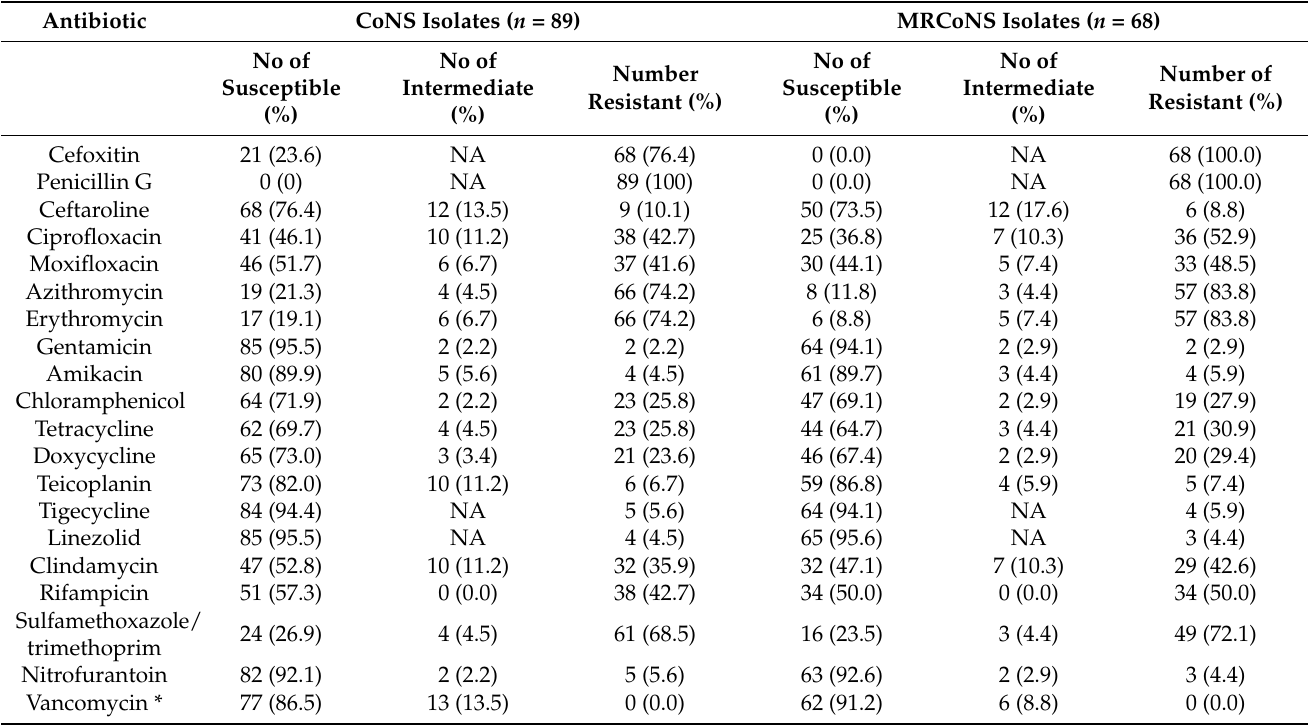
Table 1. Antimicrobial susceptibility pattern of CoNS and MRCoNS isolates from clinical sources. Antibiotic CoNS Isolates ( n = 89) MRCoNS Isolates ( n =